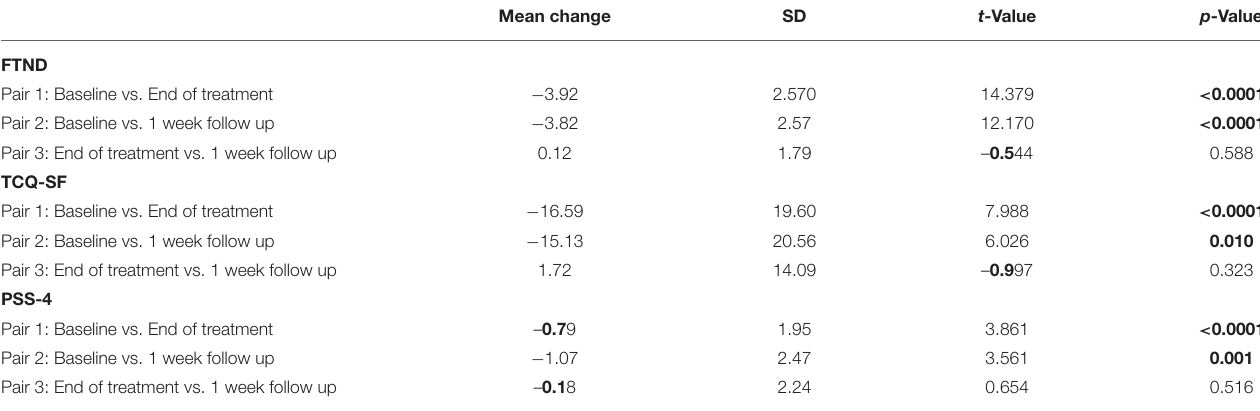
TABLE 4 | Results of paired sample t -test for the three self-reported measures. Mean change SD t- Value p